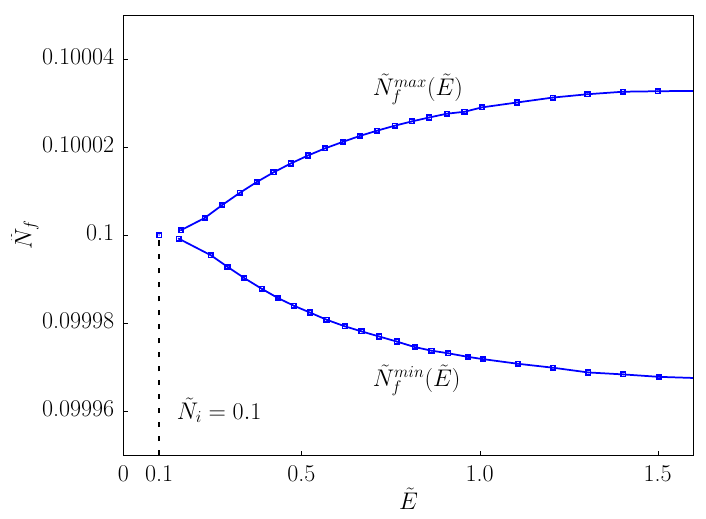
Figure 11 . The classically allowed region in ( ~ E; ~ N f ) plane for ~ N i = 10 : 0; N r = 600 ; R =